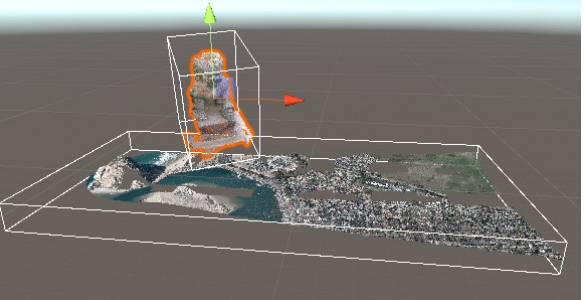
Figure 21. Virtual scene in Unity game engine to display large point clouds and stream them to an HMD, in our case Microsoft HoloLens 2